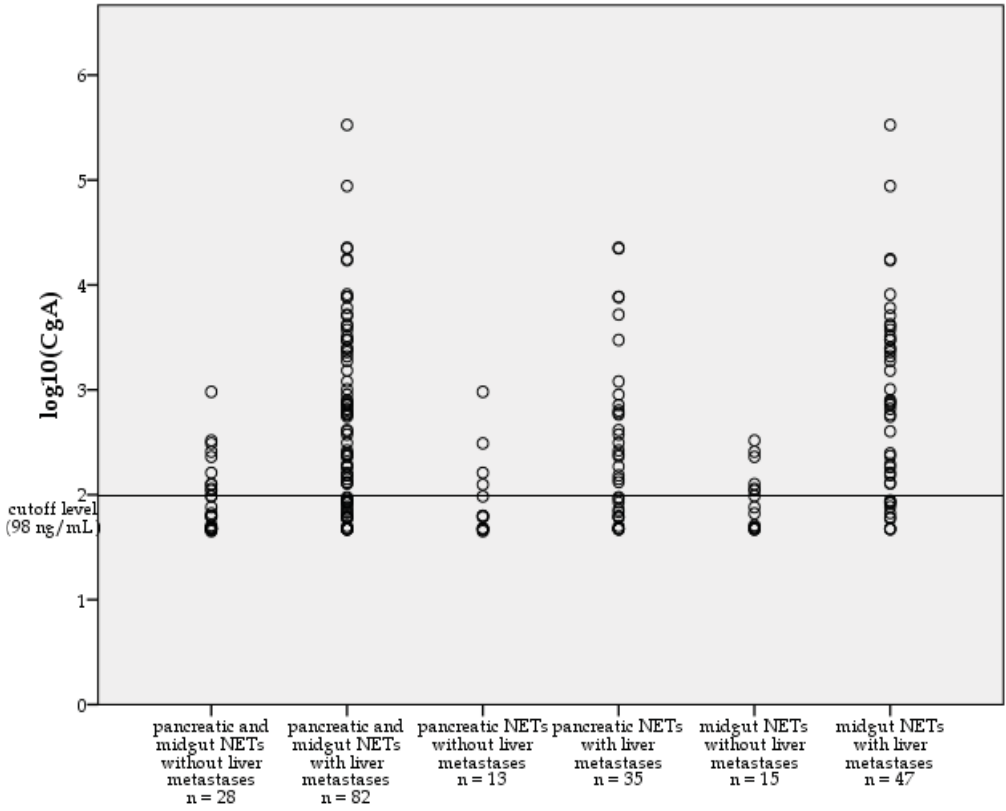
Figure 2. Log -transformed median serum CgA levels [log10(CgA), CgA in ng/mL] of 10 the whole study population (n = 110), pancreatic NET patients (n = 48) and midgut NET patients (n = 62), subdivided into patients without liver metastases and patients with liver metastases. n = number of